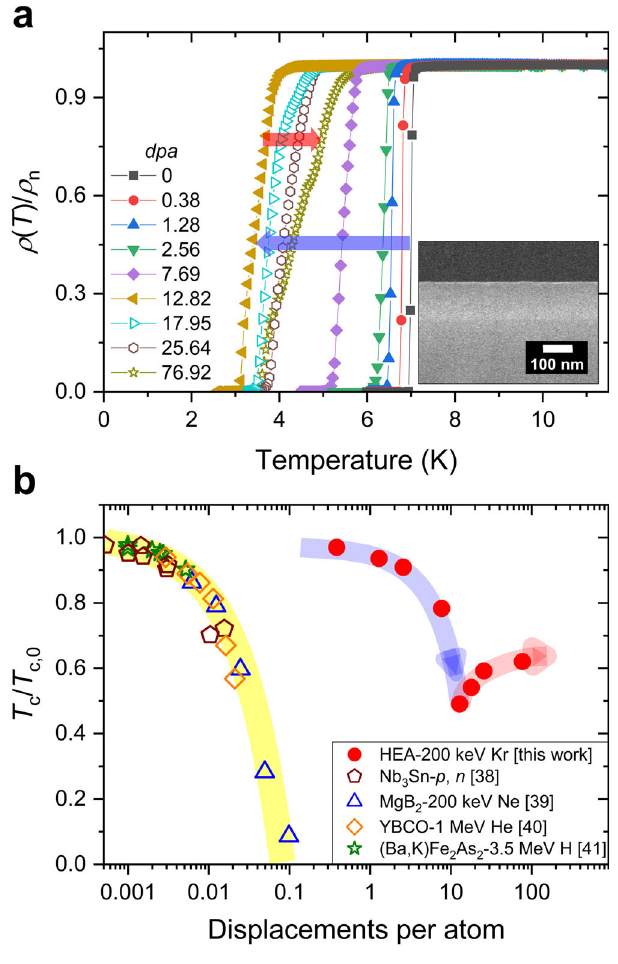
Fig. 4 Changes in SC transition temperature for HEA SC thin fi lms against irradiation damage. a ρ ( T ) curves near T c for the 200keV Kr-ion- irradiated Ta – Nb – Hf – Zr – Ti HEA SC thin fi lms with a thickness of 115nm, where ρ ( T ) was normalized by ρ n for comparison. The T c of HEA SC thin fi lms decreases gradually with an increase in dpa , but for dpa >12.82 (left triangles), strikingly, the T c exhibits an increase despite the increase in the dpa level (see the arrow direction). b T c / T c,0 with respect to dpa for representative SC materials with potential for practical applications, where T c,0 represents the T c of the pristine sample and p and n for Nb 3 Sn indicate proton irradiation and neutron irradiation, respectively. The Ta – Nb – Hf – Zr – Ti HEA SC thin fi lms show a remarkably robust superconductivity against irradiation-induced disorder compared with that of the other SC materials. Half-transparent shades are guides to the